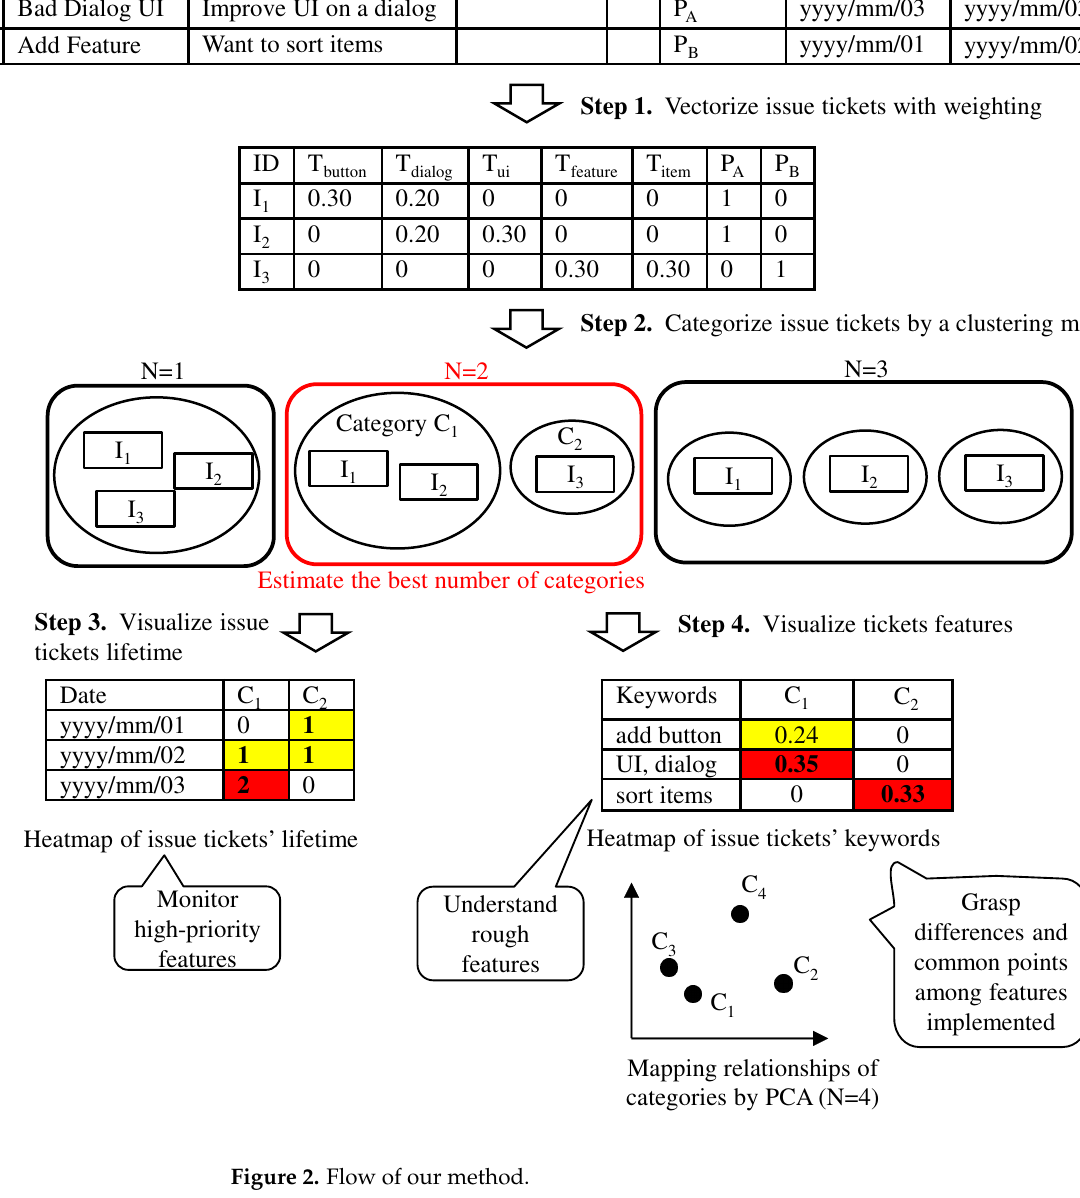
Figure 2. Flow of our